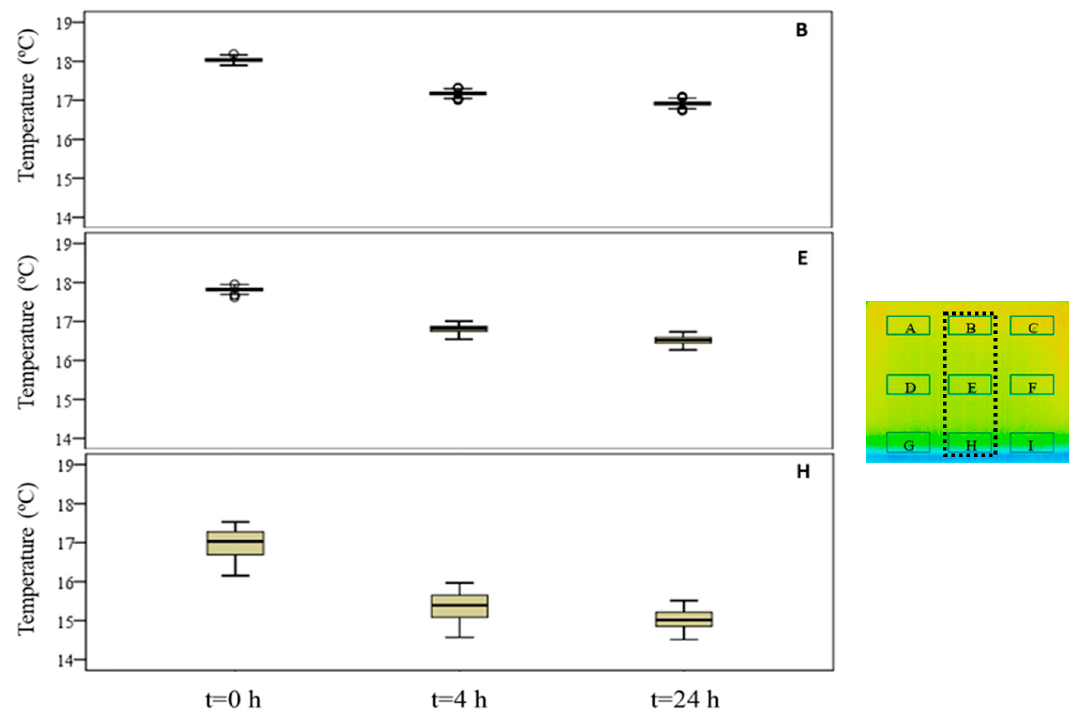
Figure 9. Box-plot representation of the surface temperatures of boxes B, E, and H.